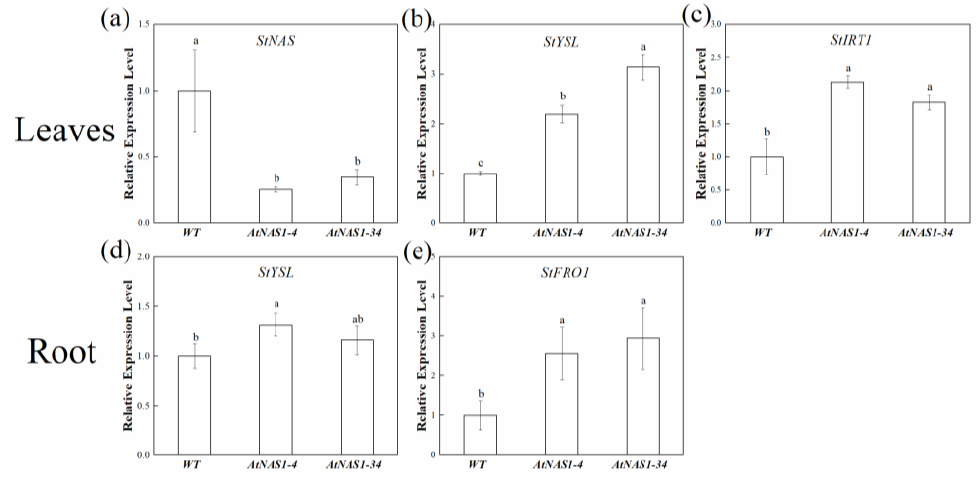
Figure 5. Analysis of mineral uptake and transport gene expression in potato. ( a ) StNAS , ( b ) StYSL , and ( c ) StIRT transcript accumulation in the leaves of transgenic and WT potato plants. ( d ) StYSL and ( e ) StFRO2 transcript accumulation in the roots of transgenic and WT potato plants. Actin (XM_006350963) was used as an internal control to normalize the expression of the transgene. The data represent means from three biological replicates. a, b, c in the picture represents significant difference. Error bars = SD. Student’s t -test was used to examine statistical significance, p < 0.05.